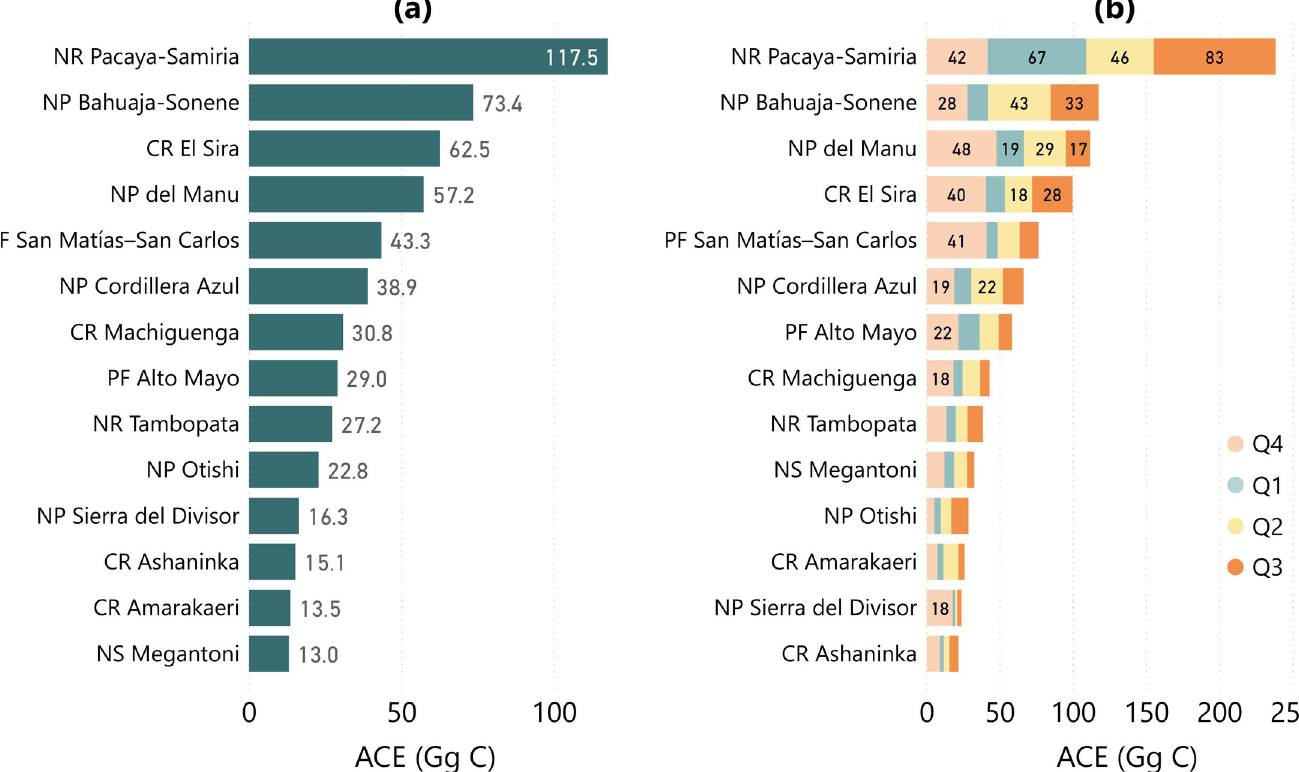
Fig 6. National protected areas with (a) high annual ACE (in Gg C) and (b) the quarterly ACE results for these areas (in Gg C). Abbreviations: National Park (NP), National Reserve (NR), Communal Reserve (CR), Protection Forest (PF), National Sanctuary (NS). Note that 1,000 Gg C = 1 Tg